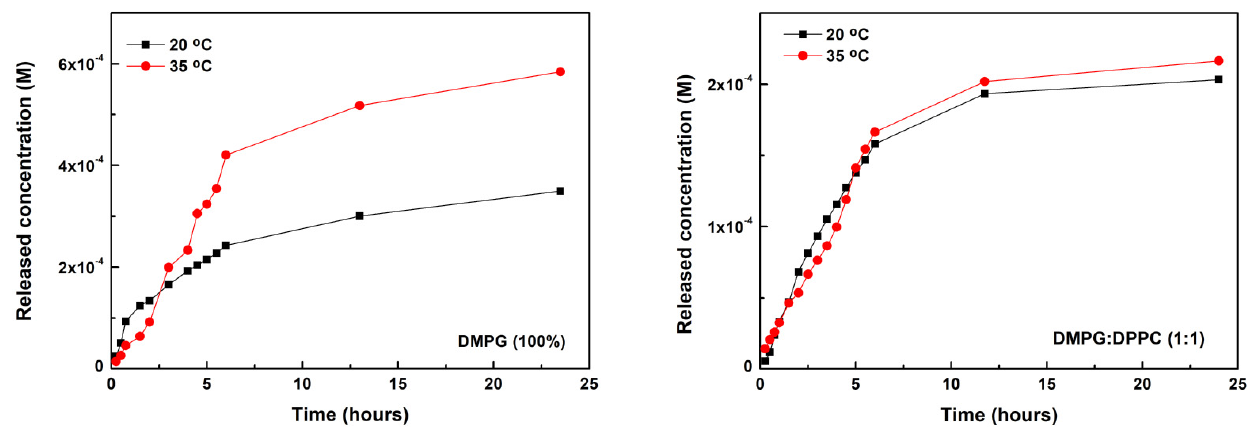
Figure 7. Cumulative release of compound 3f at 20 ◦ C (black squares) and 35 ◦ C (red dots) from liposomes of DMPG (100%) (left) and DMPG:DPPC (right).